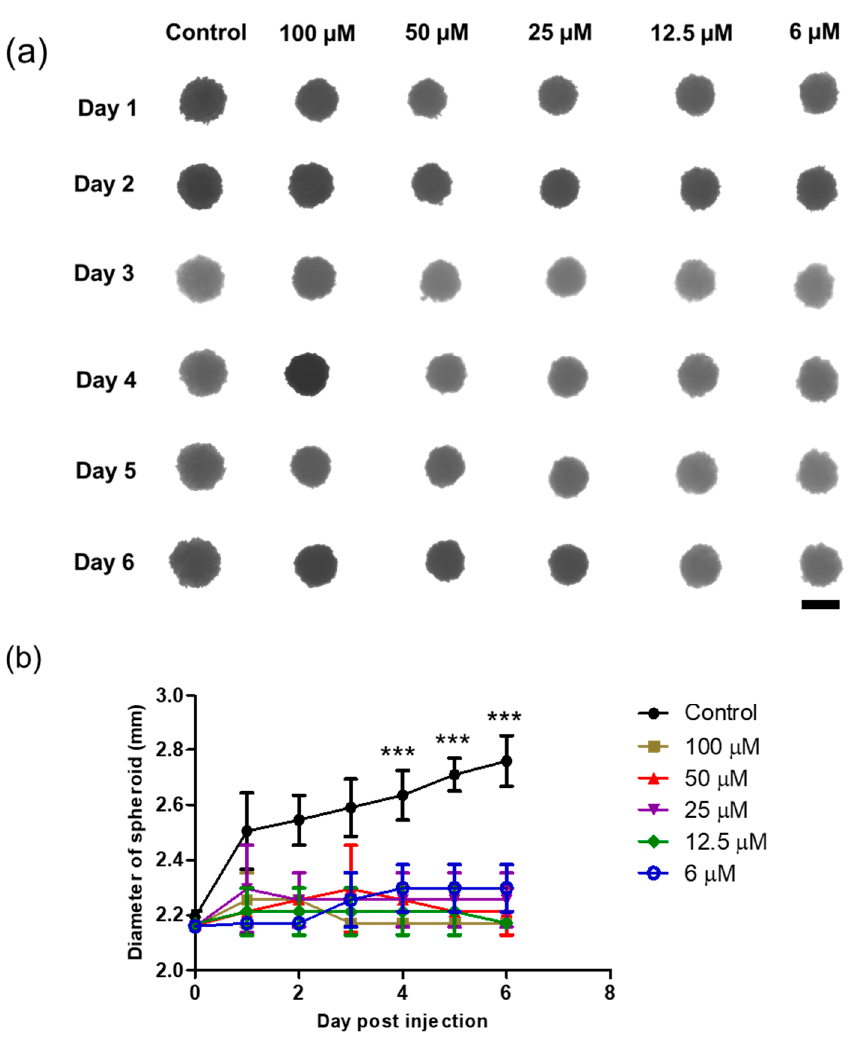
Figure 9. Three-dimensional spheroid study of the DTOS 5-5 emulsion. ( a ) Morphology and ( b ) diameter of spheroids. The scale bar represents 2.30 mm. A significant difference was observed be- tween the emulsion treatment group (25 μ M) and the control group. Data points are represented as mean ± SD of three individual copies. Statistical analysis of data was conducted using t-test (***, p < 0.001).